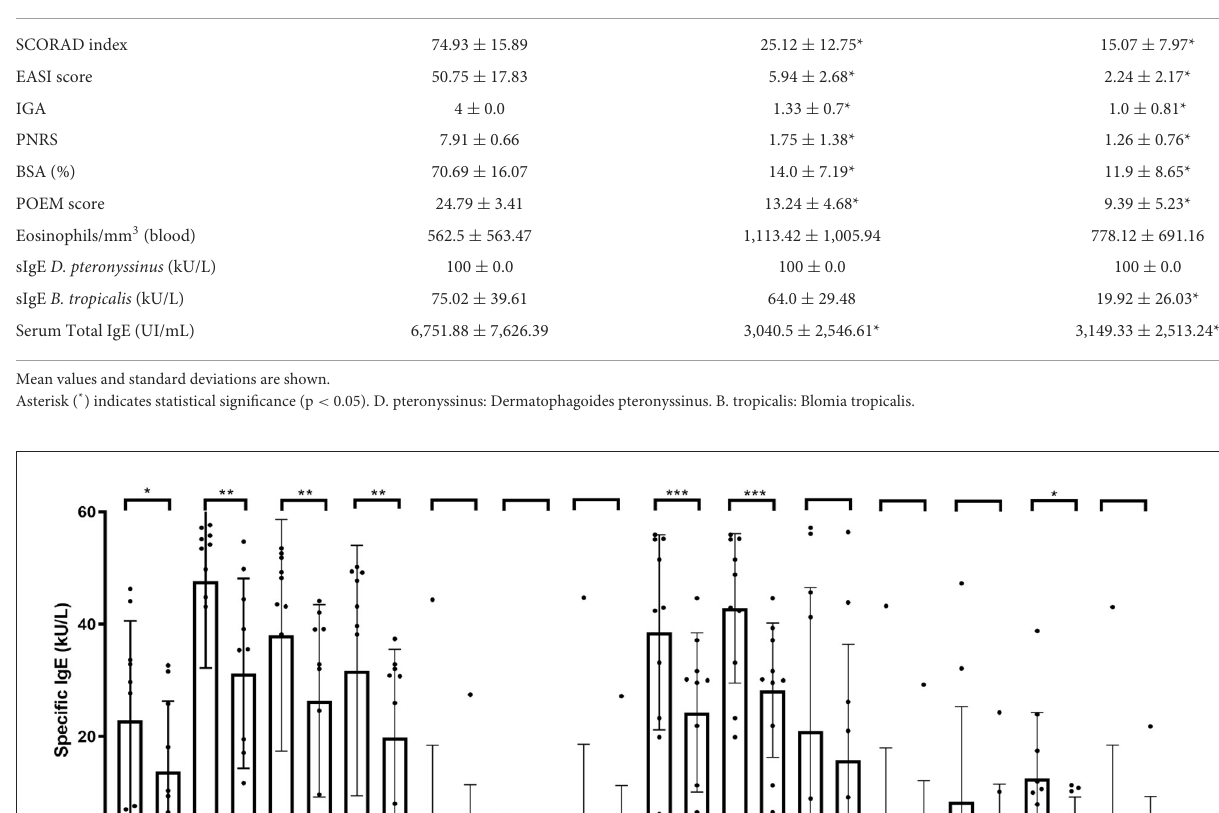
TABLE 3 Scoring features and routine laboratory testing in patients ( n = 12) with severe atopic dermatitis at baseline and follow-up after 26 and 52 weeks of treatment with dupilumab 300mg every 2 weeks for 52 weeks. Baseline